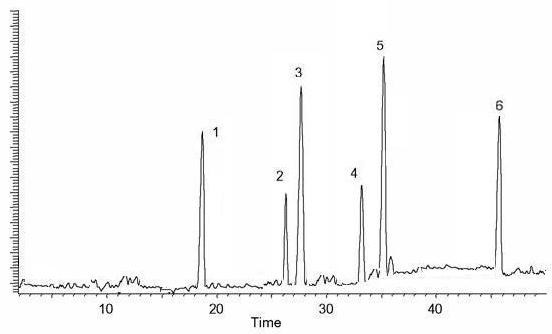
HPLC fingerprints obtained by methanolic extract of LPME Column: C18 20RBAX ECLIPSE, XDB-C18, (5 μm; 4.6 × 150 mm, Agilent USA) eluted with mixtures trifluoroacetic acid and acetonitrile indicated the presence of six compounds 1.; (kaempferol), 2.; (orientin), 3.; (rutin), 4.; (hyperuside), 5.; (quercetin) and 6.; (myricetin).